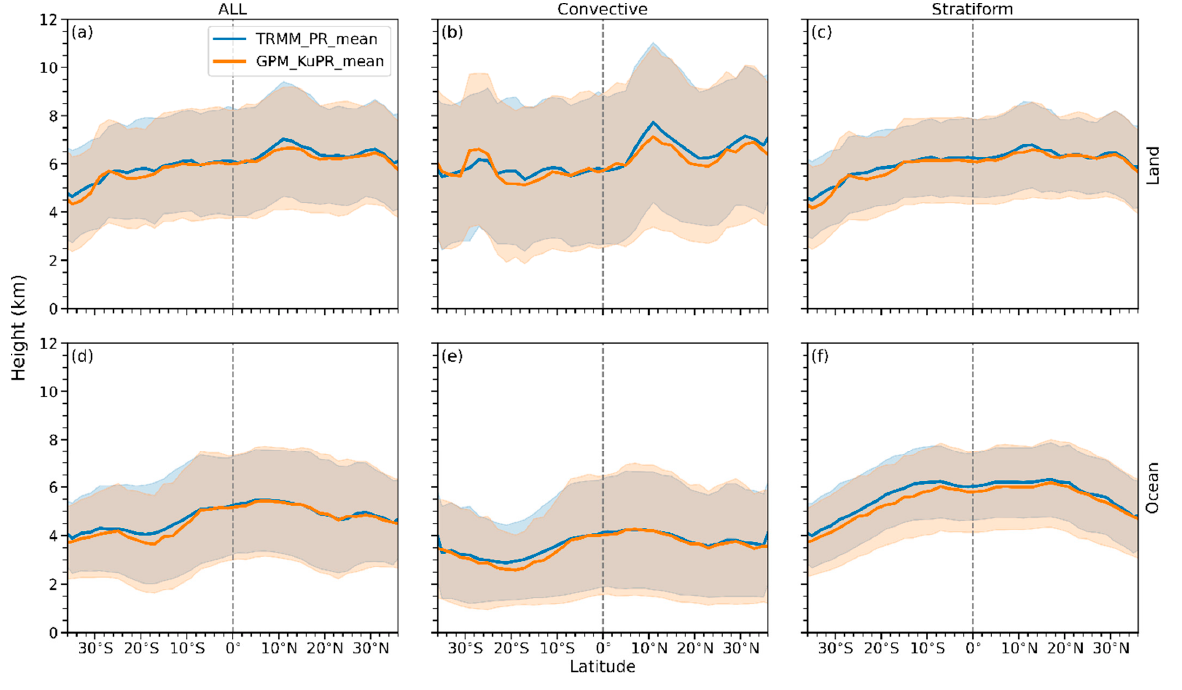
Figure 8. The mean (lines) and standard deviation (shades) of Topht20 during the overlapping period as a function of latitudes (2° resolution) from the TRMM_PR (blue) and GPM_KuPR (red) over ( a – c ) land and ( d – f ) ocean. Samples are subdivided by ALL (first column), convective (second column), and stratiform (third column) rain types.